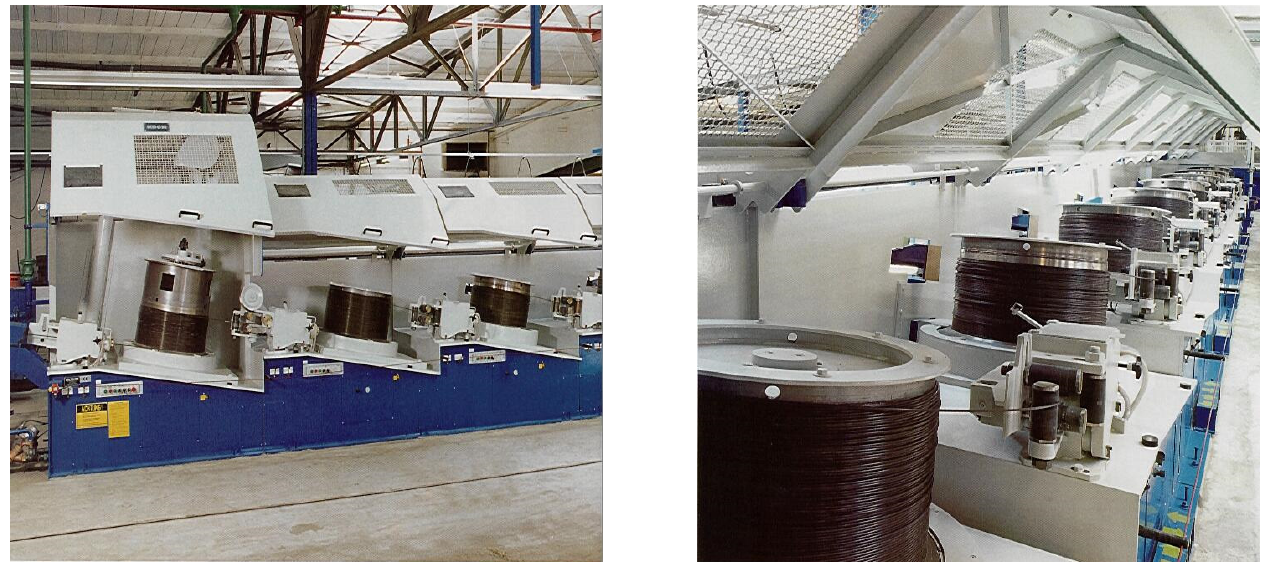
Figure 1. Manufacture of prestressing steel wires by progressive cold drawing of a previously hot-rolled pearlitic steel bar: two views of a real manufacturing chain by progressive (multi-step) cold drawing.